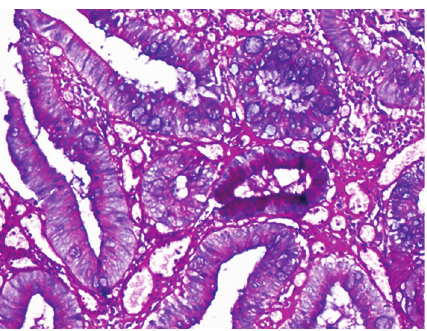
Figure 2: Metaplastic epithelium showing glands lined by goblet cells (periodic acid Schi ff with Alcian blue,